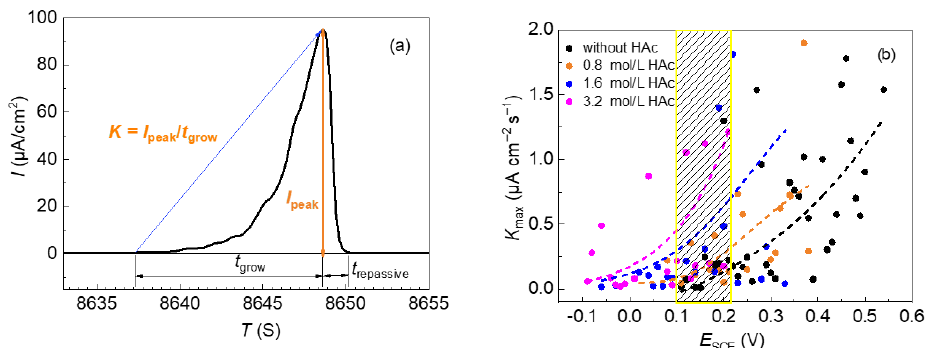
with different concentrations of HAc was statistically analyzed. Figure 5a shows a typical current transit fluctuation of 304 SS in the slow-scanning potentiodynamic polarization test, including the annotation of the parameters. It can be seen that the growth rate of the metastable pit can be divided into two stages, the first, shorter, stage of which demonstrates a slower rate, while the second, longer, stage shows a quicker rate. In this work, the average growth rate in the second stage of each current fluctuation was used to represent the average growth rate of a metastable pit. Because the five parallel tests produced many data points, the entire potential region involving all current fluctuations was divided into several sections, using 10 mV as an interval. In each potential section, the biggest average growth rate ( K max ) of the metastable pit was selected and the influence of HAc concentration was analyzed. Figure 5b presents the largest average growth rate ( K max ) in the different potential sections. It can be seen that the values of K max are mainly in the range of 0–2.0 µ A cm − 2 /s. In order to show the comparisons more clearly, the trend of the data points was fitted under each solution condition, which is shown by the dotted line. At the same potential (the shaded area in Figure 5b), the value of K max increased with increasing HAc concentration. This demonstrates that the presence of HAc has a promoting action on the growth rate of metastable pits on 304 SS.